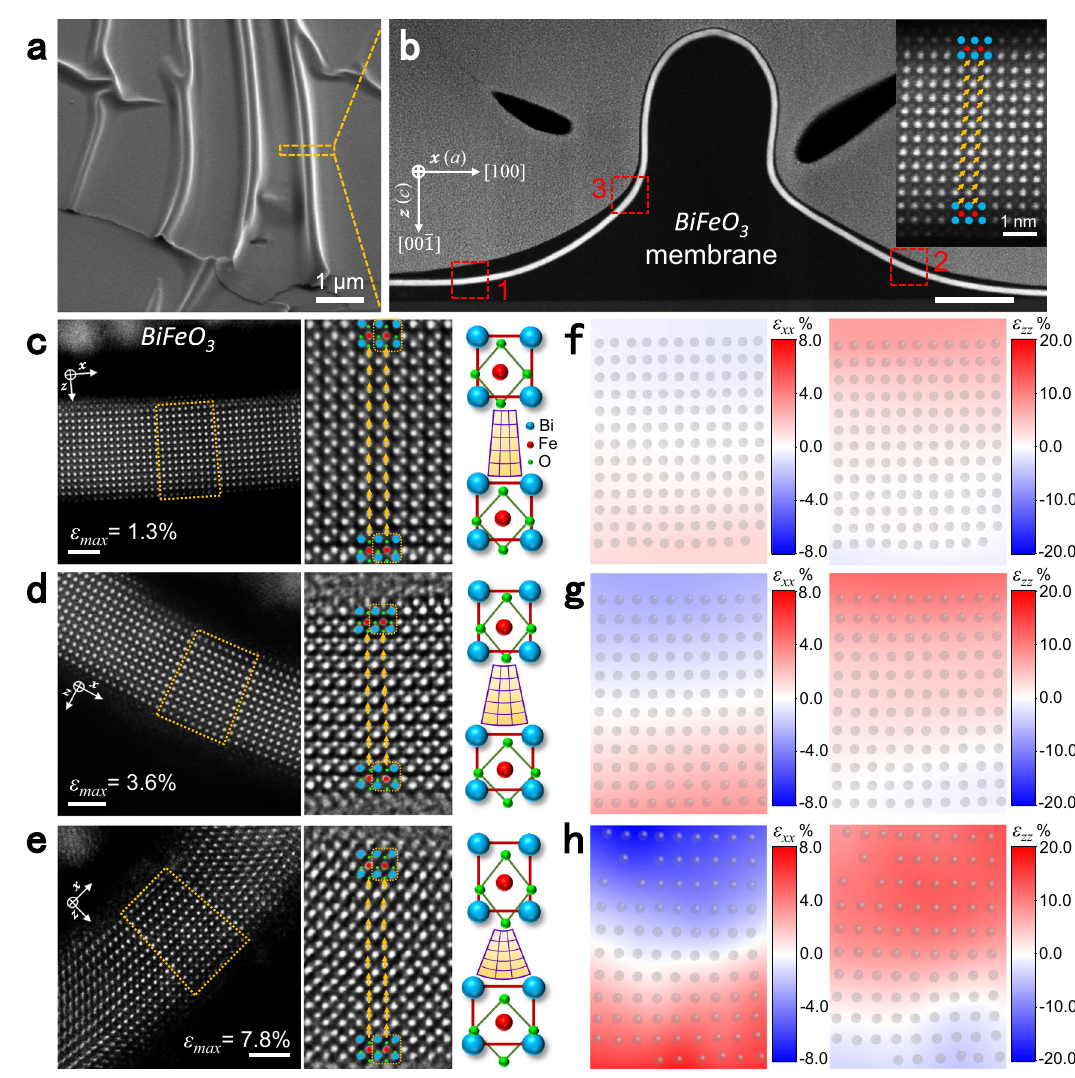
Fig. 1 | Bending behavior of BFO membranes. a Scanning electron microscope (SEM)imageofwrinkledfreestandingBFO.Scalebar:1 μ m. b Cross-sectionalSTEM- HAADF image of a single wrinkle in ( a ). Scale bar: 100nm. Inset indicates the unstrained state taken from region 1 (marked by red square), where the sponta- neous polarization has an upward out-of-plane component (yellow arrow). c – e STEM-HAADF images (left) taken from the bent regions 1, 2, 3 in ( b ), respec- tively. The strain gradients ε xx,z are 5.2×10 6 m − 1 , 2.1×10 7 m − 1 , and 3.5×10 7 m − 1 ,